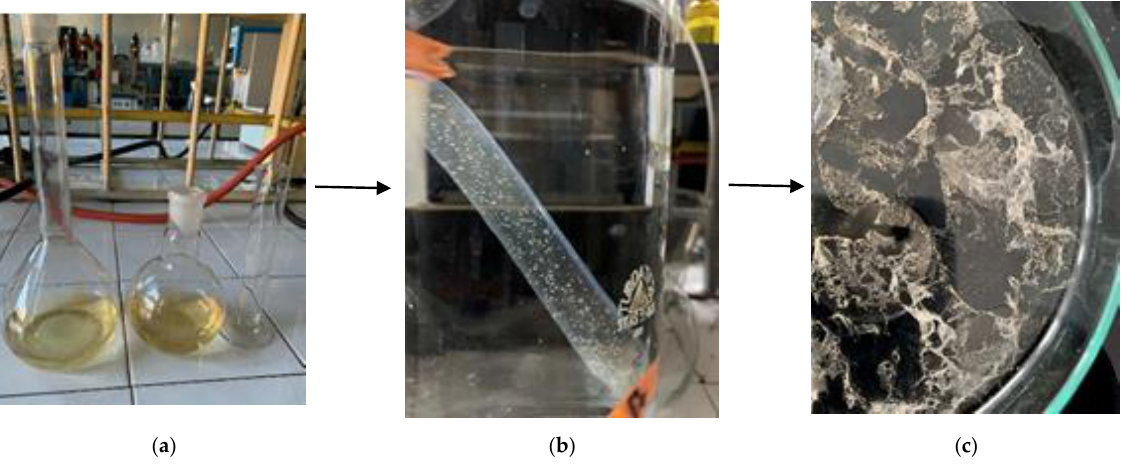
Figure 12. Separation of chitin fractions from the deproteinization liquid extract: ( a ) LC extract; ( b ) insolubilized pellets after dialysis in D 2 O and ( c ) purified chitin fractions for analysis.